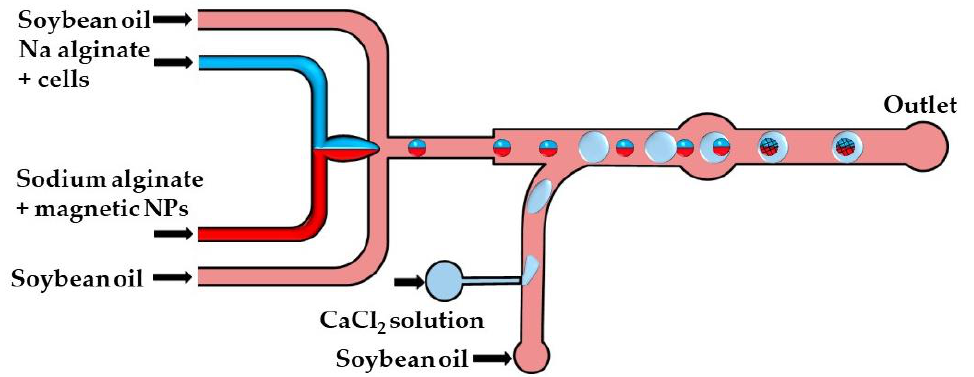
Figure 14. Formation of alginate/magnetic Janus beads by droplet merging in the chip consisting of head-on junction/flow focusing junction for the generation of Janus droplets, a side channel for the introduction of CaCl 2 droplets and a fusion chamber for merging the Janus and CaCl 2 droplets [64].